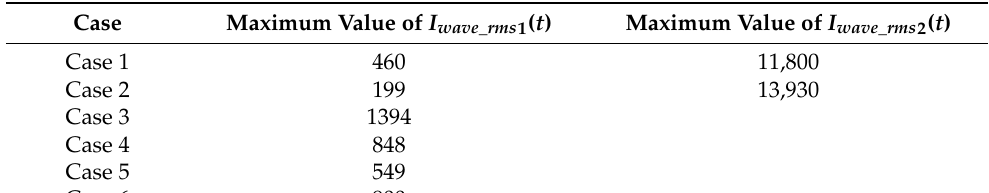
Table 4. Maximum value of I wave_rms 1 ( t ) and I wave_rms 2 ( t ) at Cases 1–6.